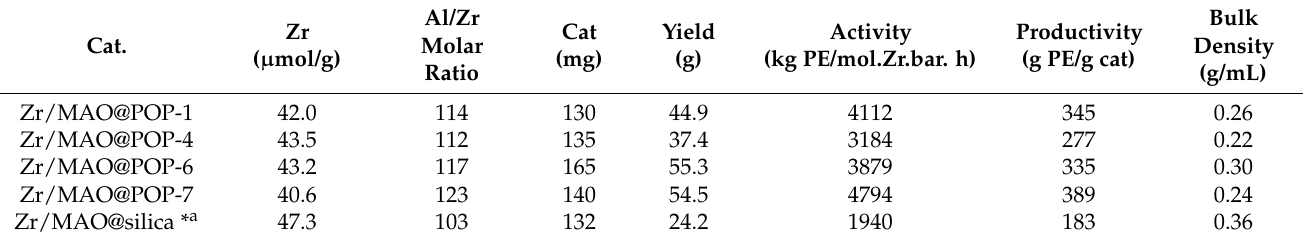
Table 4. Ethylene polymerization results (catalyst: (n-BuCp) 2 ZrCl 2 /MAO supported on nano TiO 2 -doped POP Particles e .